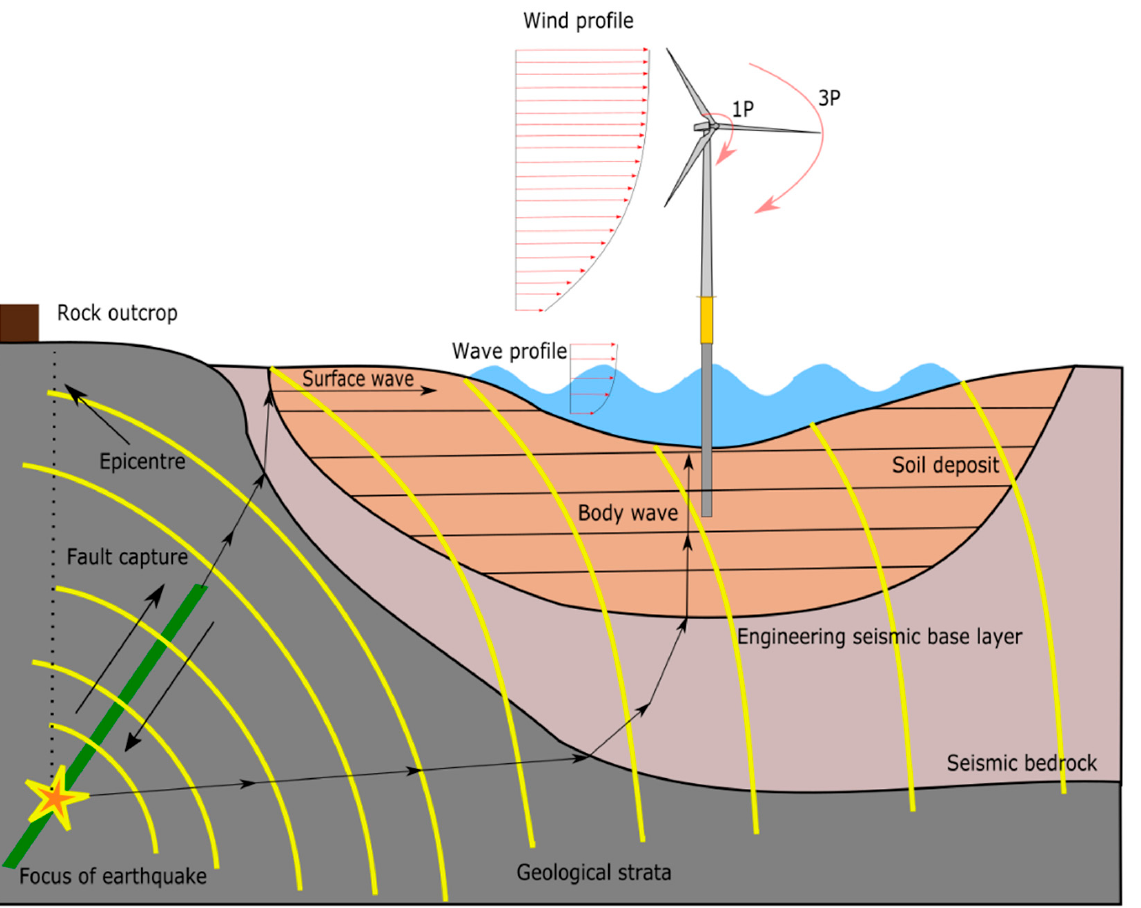
Figure 6. Loading conditions for seismic locations.